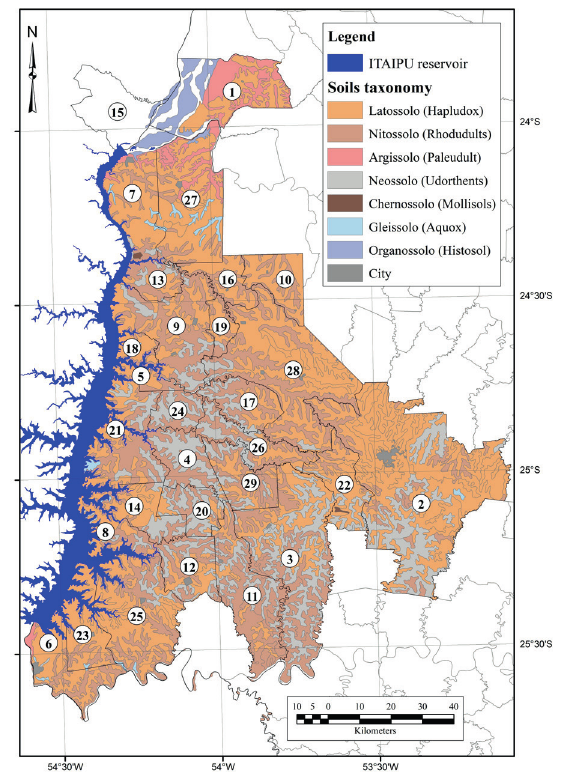
Figure 4 - Map of soils of the Paraná Watershed III